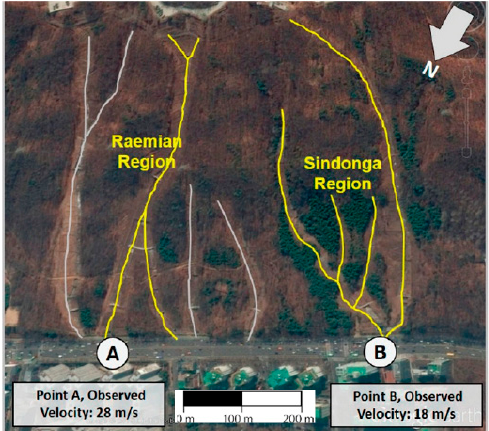
Figure 11. The flowpaths of the debris-flow that affected the Raemian and Sindonga regions are marked with yellow lines [16].